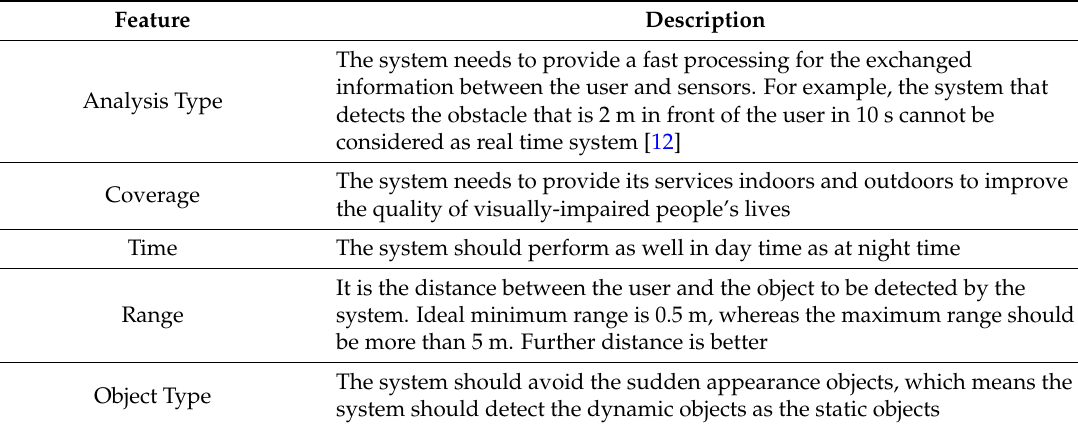
Table 1. The most important features that correspond to the user’s